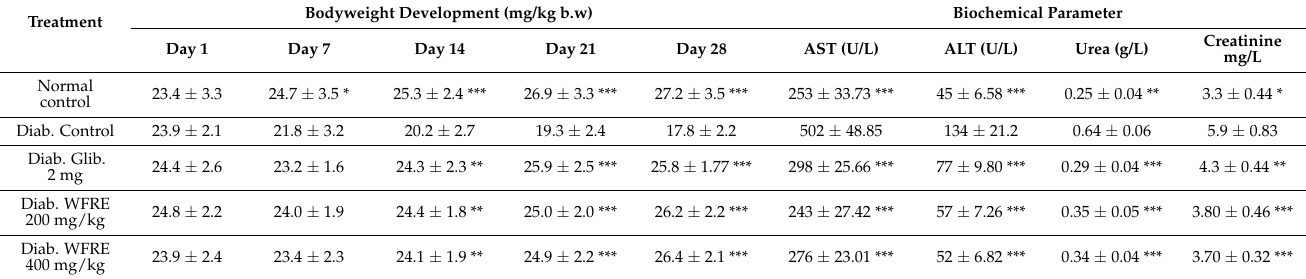
Figure 3. Plant extract effect on alloxan-induced diabetic mice during the 12 h of the antihyperglycemic test. Table 1. Effect of plant extract on body weight and biochemical parameter